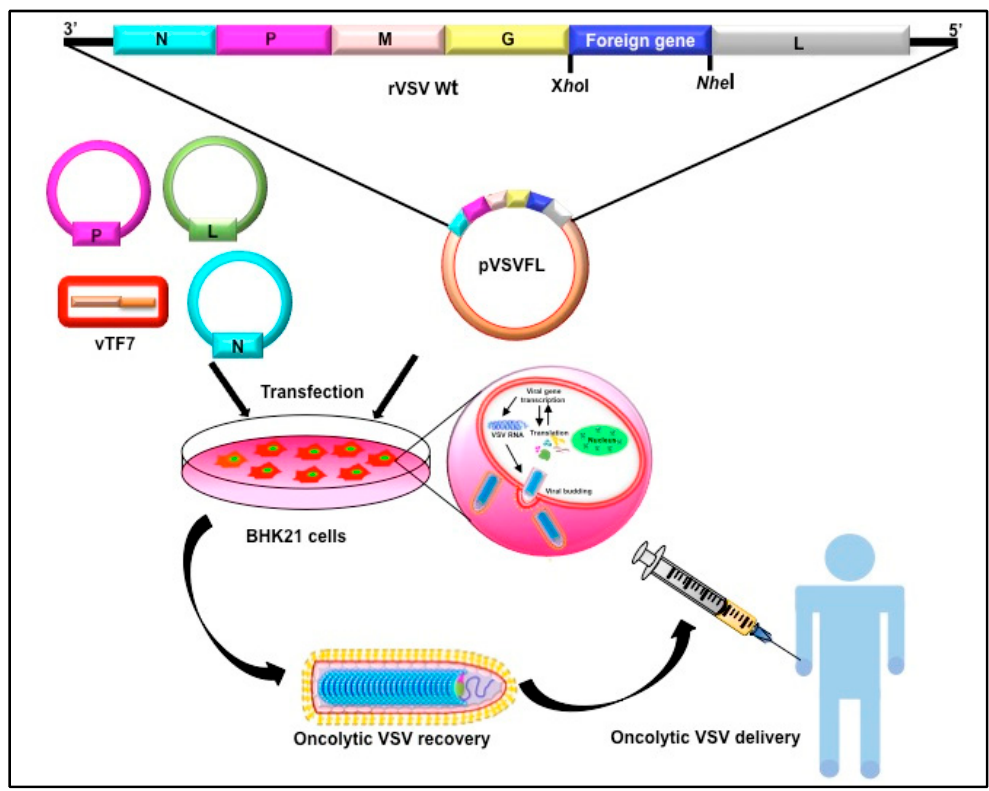
Figure 2. Reverse genetics use in making customized VSV targeting tumor lysis. Schematic presentation of VSV reverses genetics system. Plasmid DNA harboring full-length viral genome and other accessory proteins are transfected to the supporting cell line to initiate virus genome transcription and